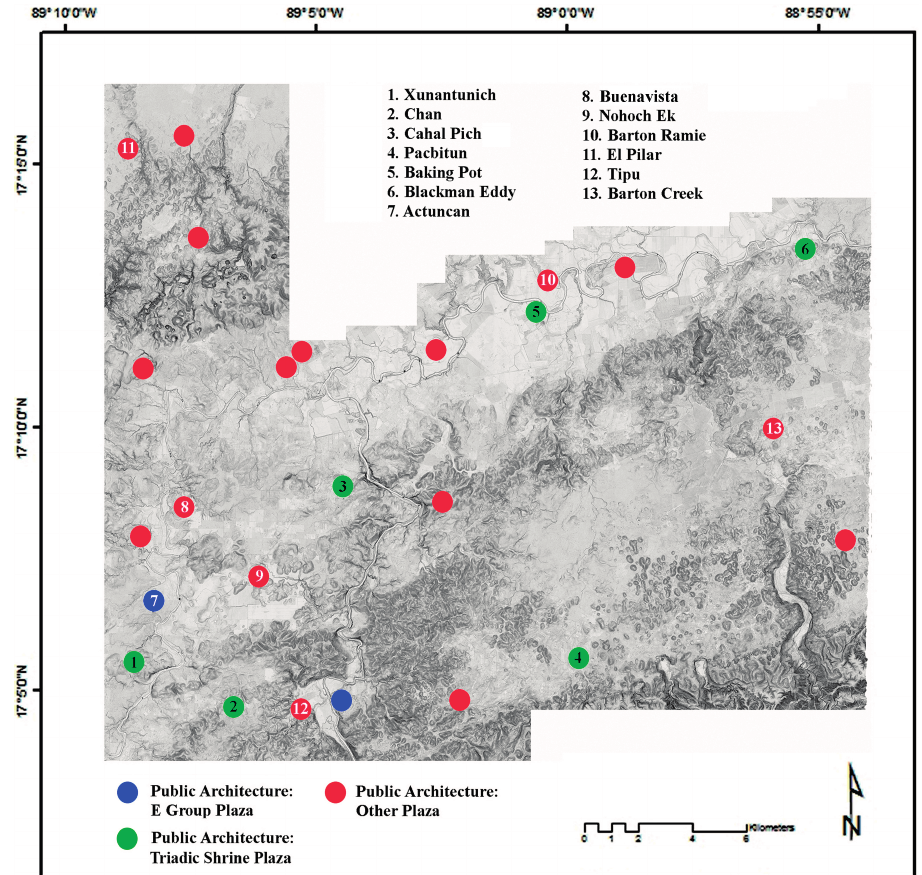
Figure 6. The 2013 LiDAR DEM of the northern survey area, representing the Belize Valley, showing the distribution of sites with public architecture. Architectural complexes mentioned by name in the text are numbered. The Macal (on which Site 12 is located) and Chiquibul (on which Site 1 is located) Rivers join together at the modern city of San Ignacio (north of Site 3) to form the Belize